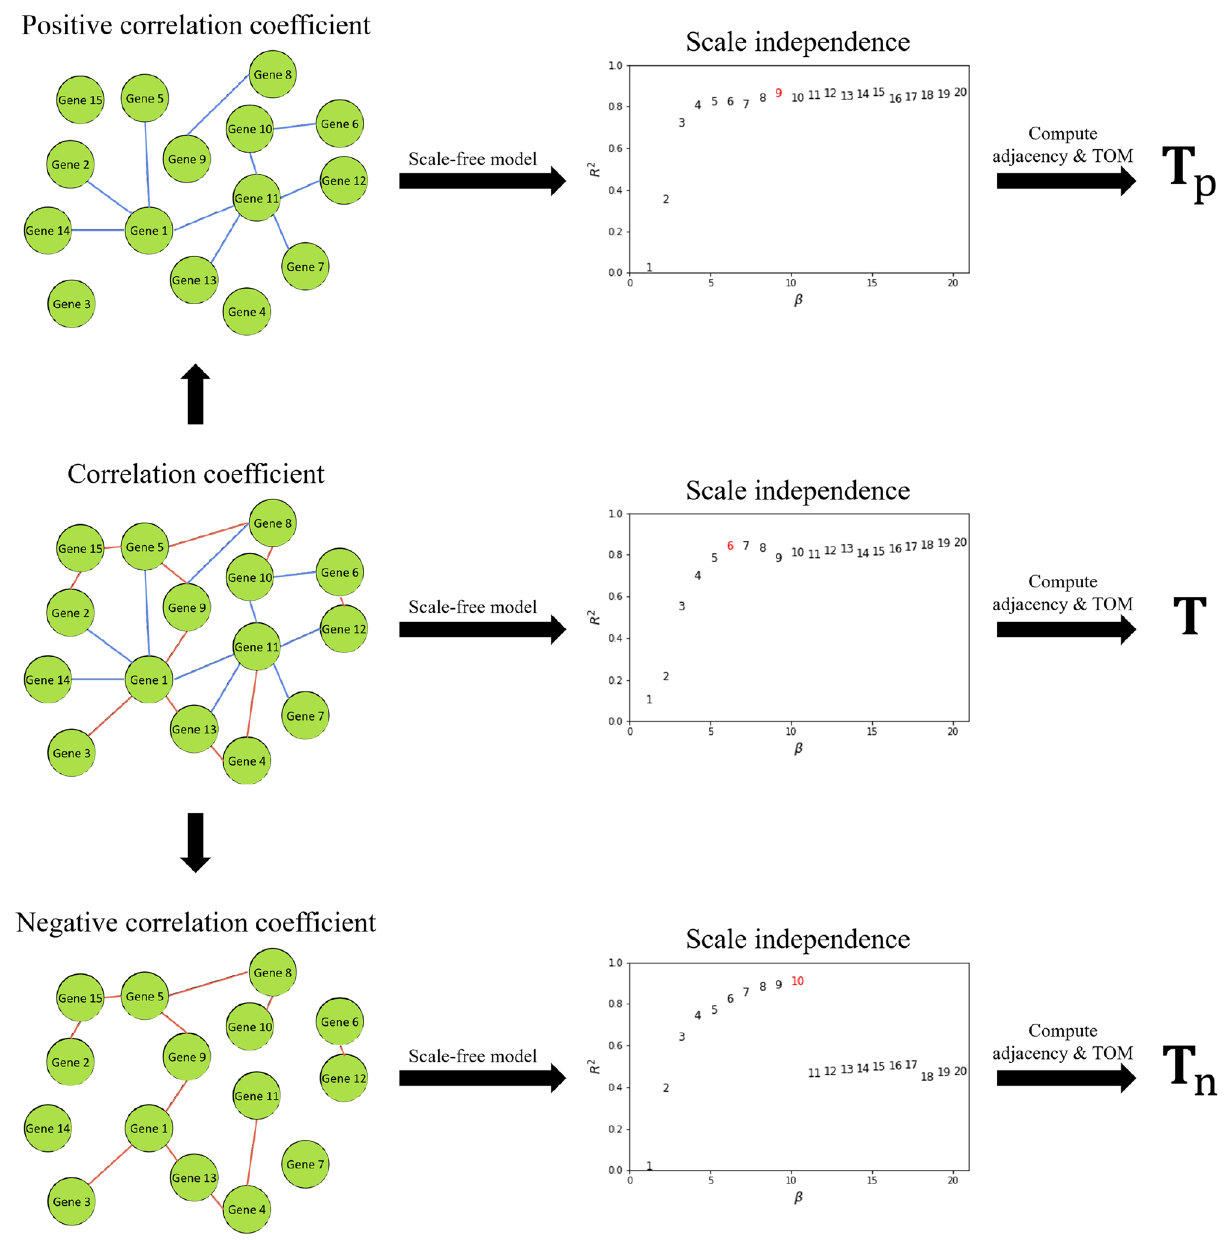
Figure 7. Construction of three topological overlap matrices. T is the topological overlap matrix of all relationships. T p and T n are the topological overlap matrices of positive and negative relationships